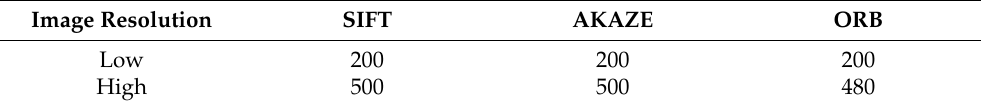
Table 1. The minimum number of features required (threshold values) for successful image matching. Image Resolution SIFT AKAZE ORB Low 200 200 200 High 500 500